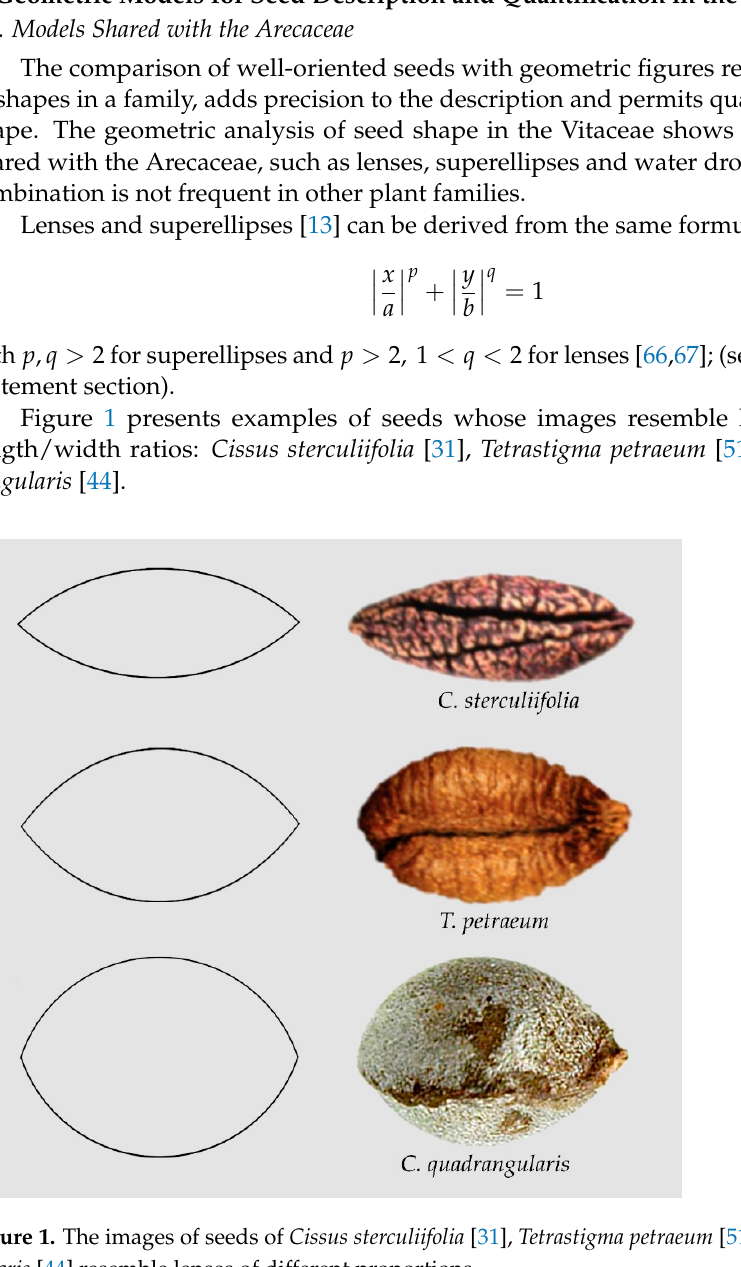
Figure 2. Examples of seed images resembling superellipses with different length/width ratios: First row: Tetrastigma henryi [51]. Second row: Tetrastigma campylocarpum [51]. Third row: T. caudatum [51].